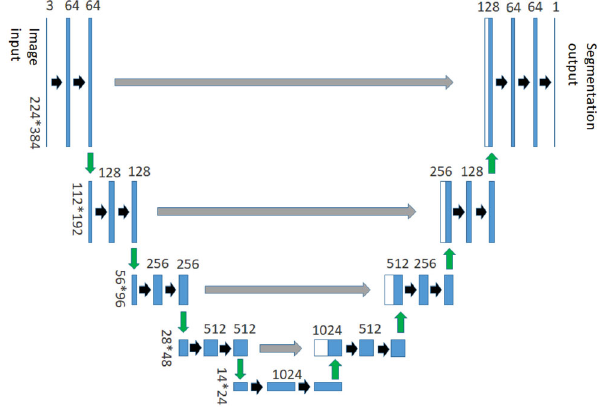
Fig. 3 Modified U-net network